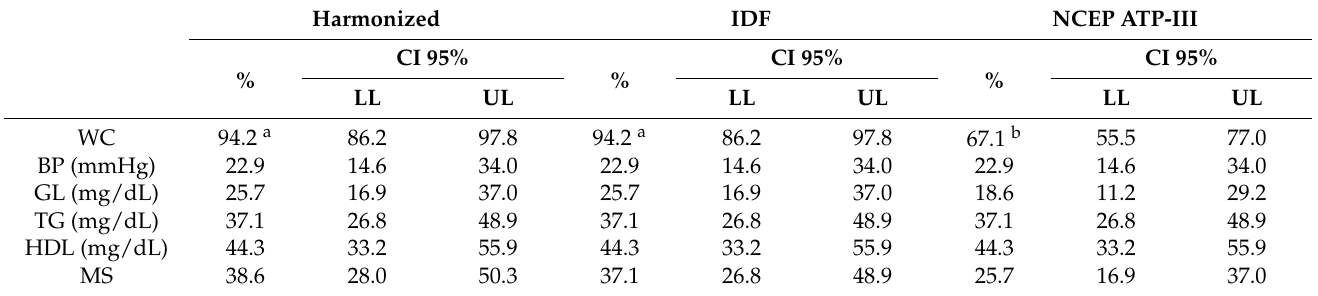
Table 2. Frequency distribution (%) and 95% confidence interval (95% CI) of the presence of metabolic syndrome (MS) according to harmonized, IDF, and NCEP ATP-III criteria.